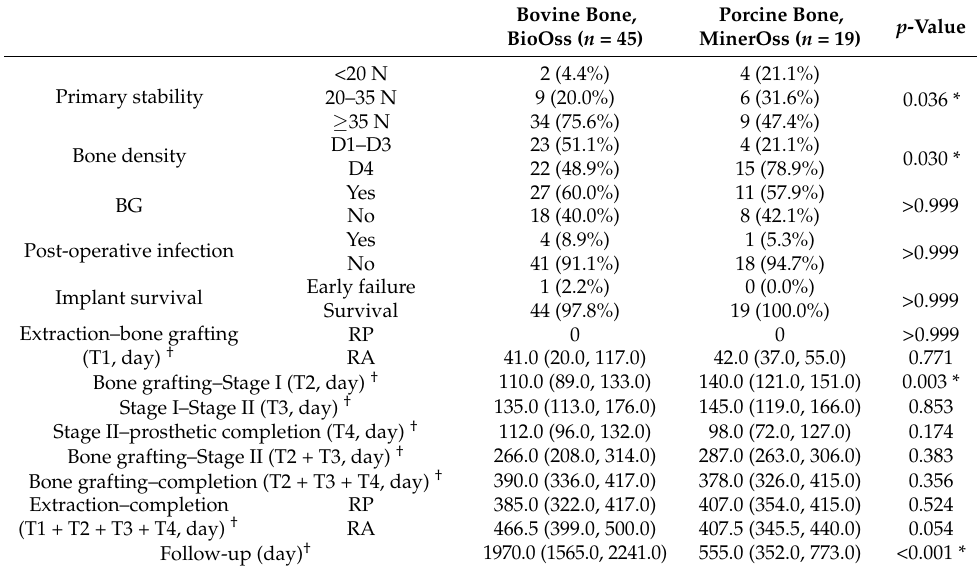
Bovine Bone, Porcine Bone, p -Value BioOss ( n = 45) MinerOss ( n = 19)